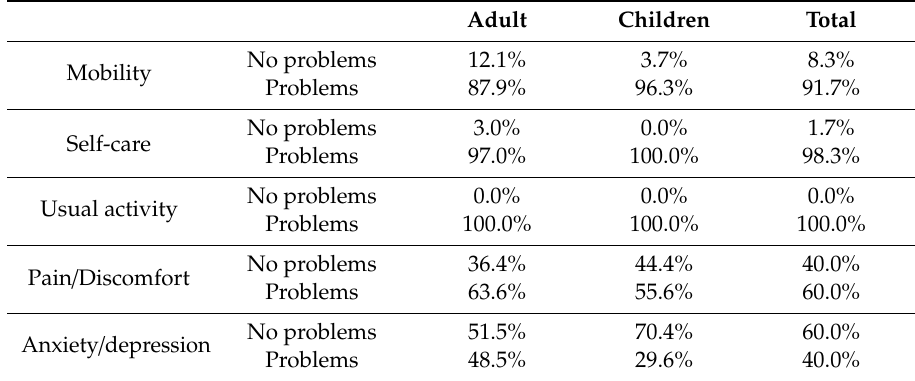
Table 1. The percentage of reported problems for each QoL dimensions divided by adult and